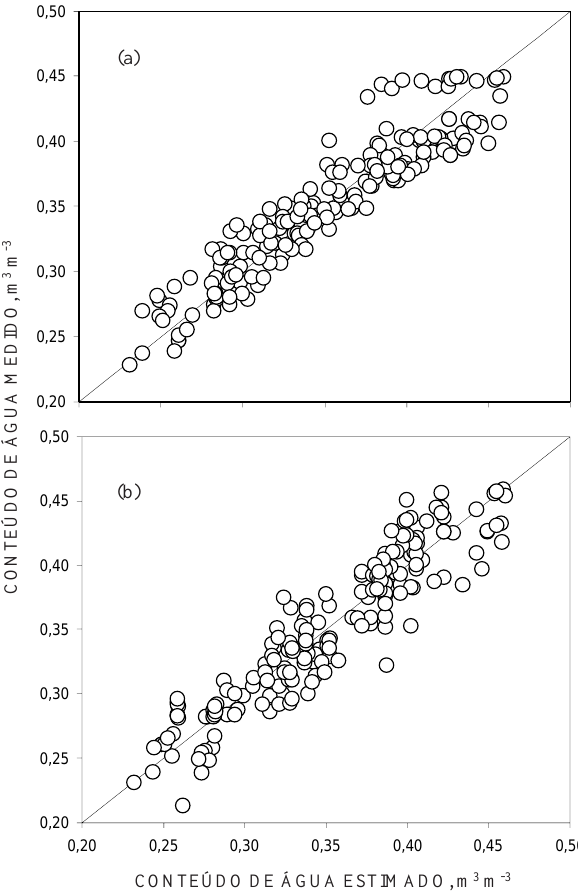
Figura 3. Conteúdo de água medido versus estimado pelas funções de VG (a) e HC